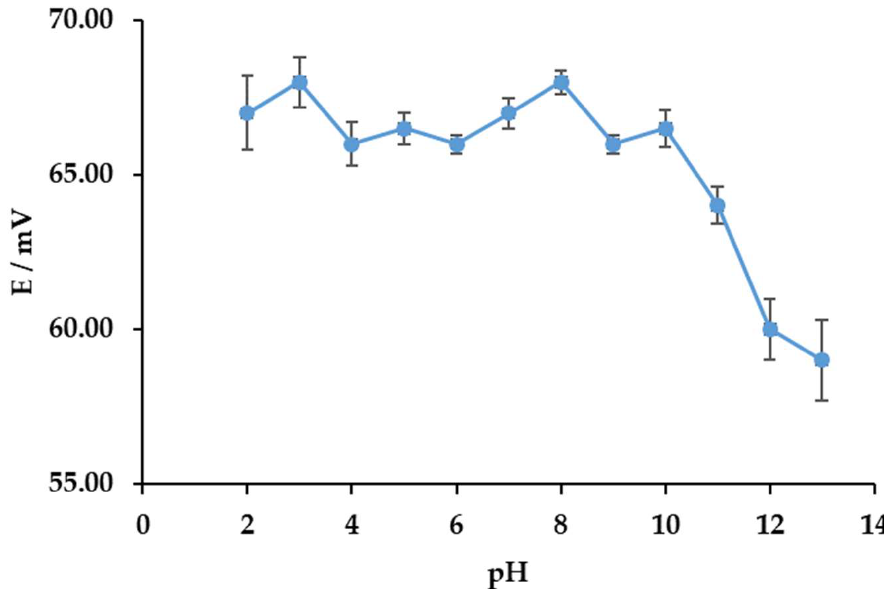
Figure 2. Investigation of the pH influence on the response characteristics of the DODI-TPB surfactant sensor to CPC (0.5 mM) (standard deviation errors bars included).